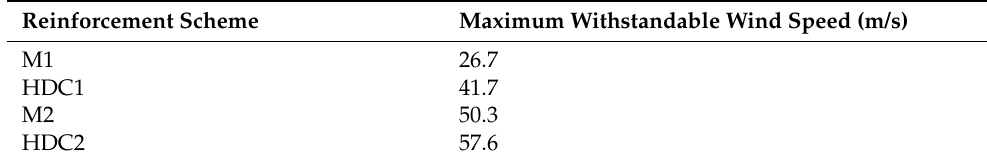
Table 4. The maximum withstandable wind speed of keel brick walls under different reinforcement schemes.